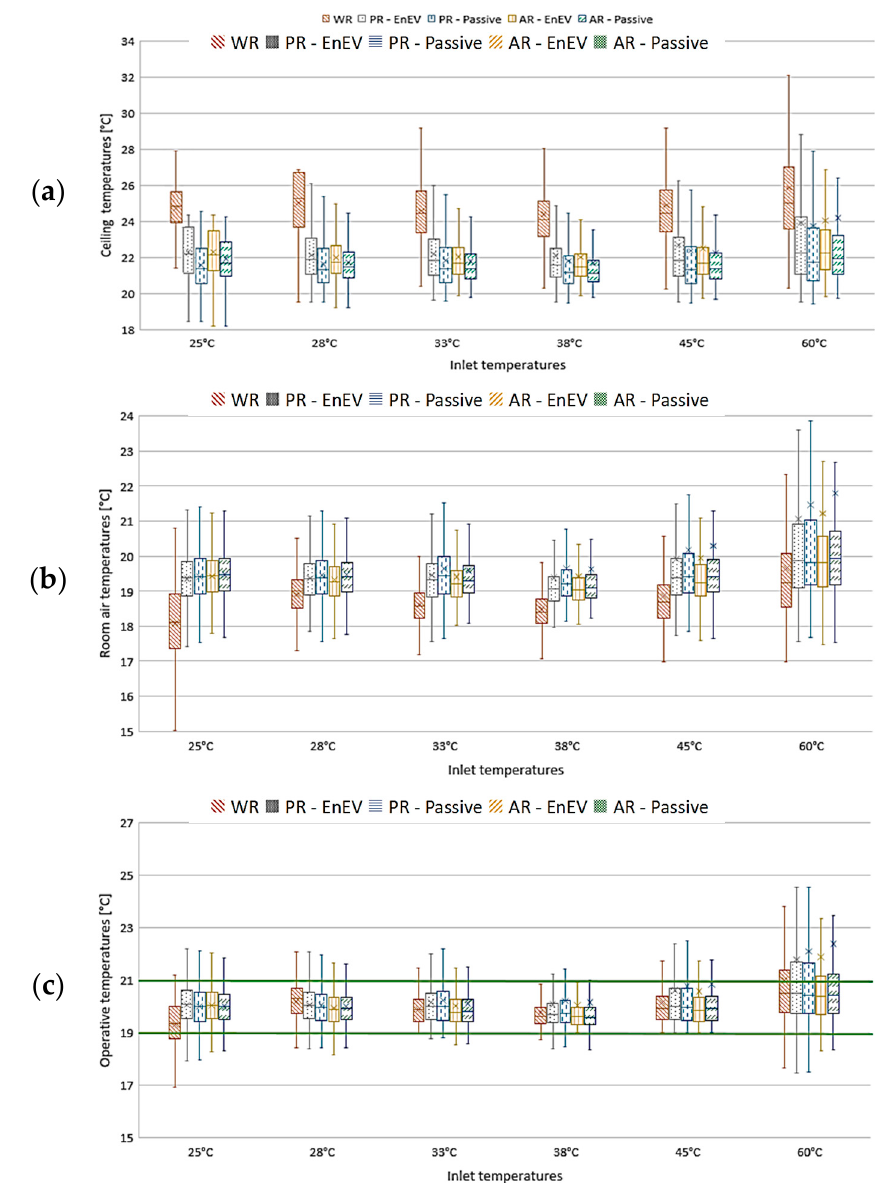
Figure 8. ( a ) Radiant ceiling temperatures, ( b ) Room air temperatures, and ( c ) Room operative temperatures associated with different supply water temperatures and different renovation scenarios on the first floor. The ceiling temperature depends on the control operation model in the way that the indoor operative temperature at the height of 60 cm (middle point of a sedentary person) lays between 19–21 °C. WR: Without renovation; PR: Partially renovated; AR: Ambitious renovation.